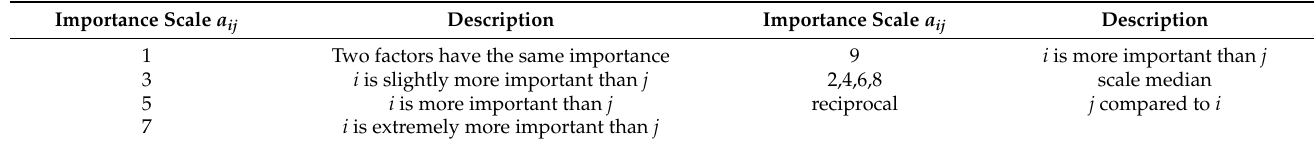
Table 2. Indicator importance scale.